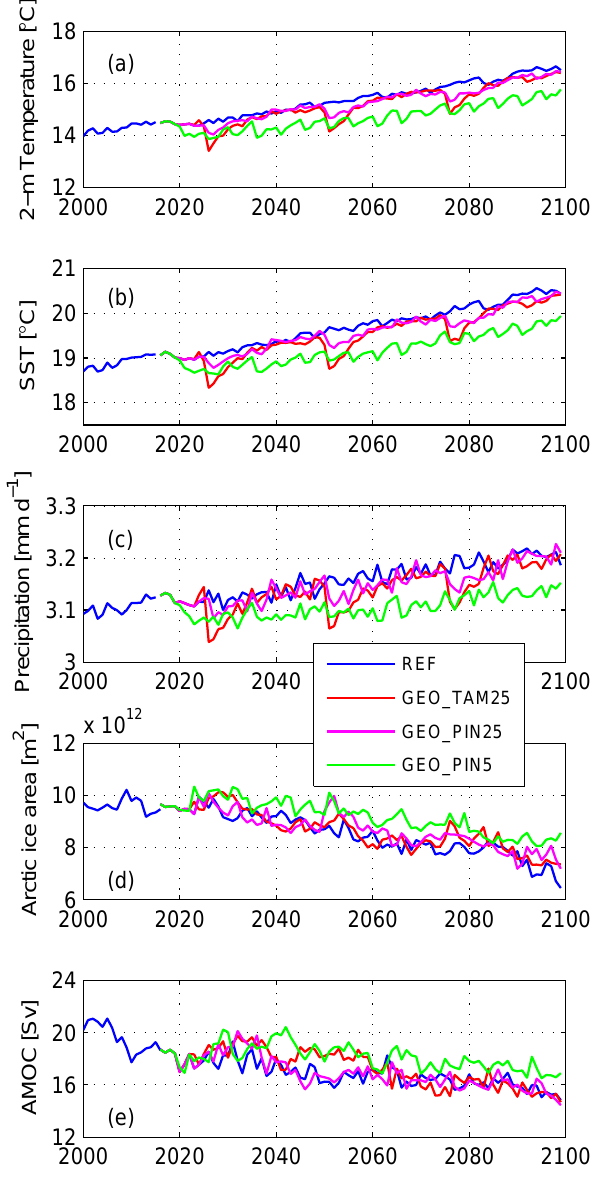
Fig. 4. Model projection of global mean (a) 2-m surface air tem- perature, (b) sea surface temperature, (c) precipitation, (d) summer (September) Arctic sea ice area, and (e) Atlantic Meridional Over- turning Circulation (AMOC) strength for each